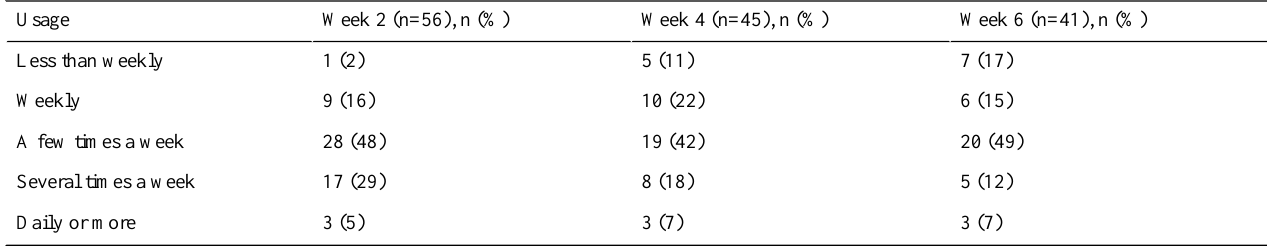
Table 4. Usage data for the intervention group at each time point. Adherence was defined as using the app weekly or more frequently, measured via